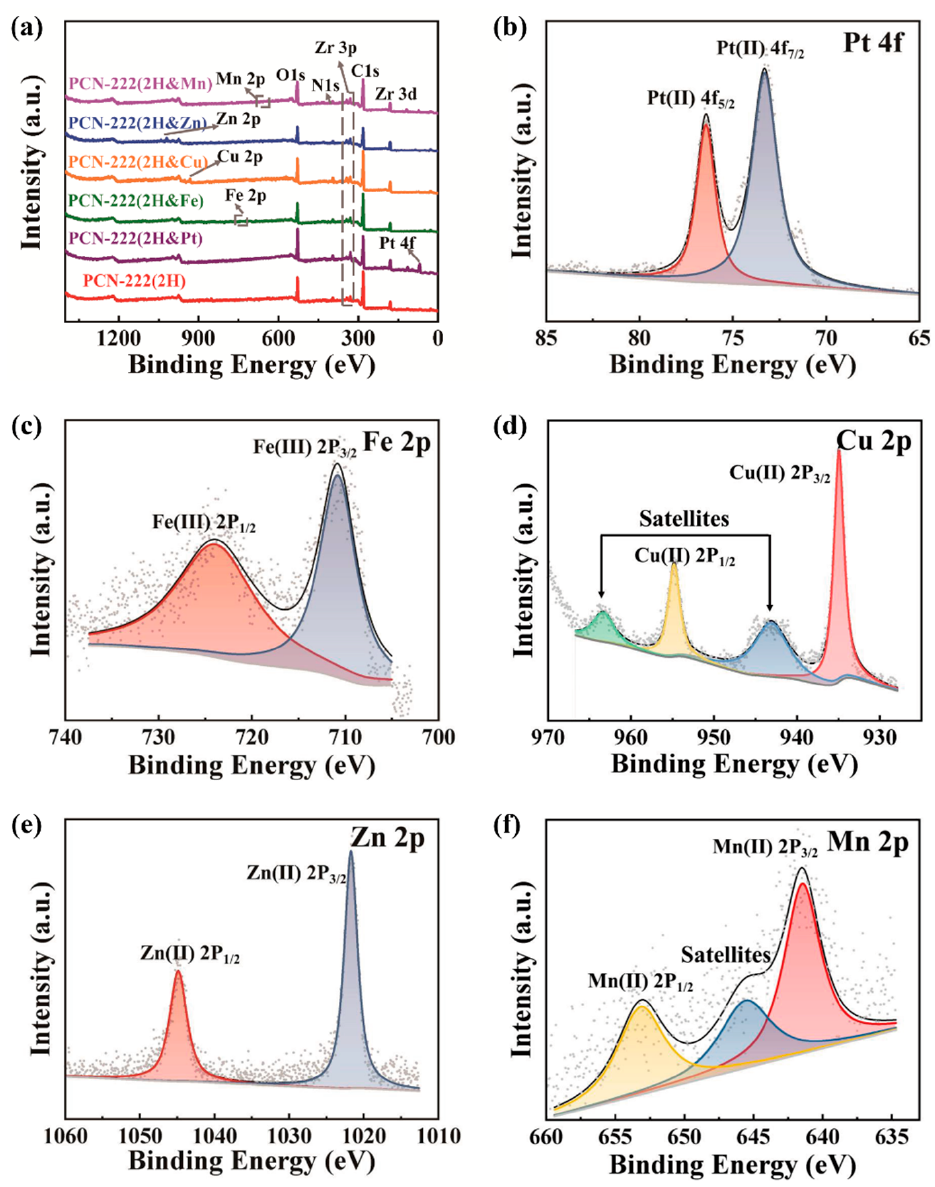
Figure 2. ( a – f ) XPS spectra: ( a ) survey of PCN-222 materials, ( b ) Pt 4f of PCN-222(2H&Pt), ( c ) Fe 2p of PCN-222(2H&Fe), ( d ) Cu 2p of PCN-222(2H&Cu), ( e ) Zn 2p of PCN-222(2H&Zn), and ( f ) Mn 2p of